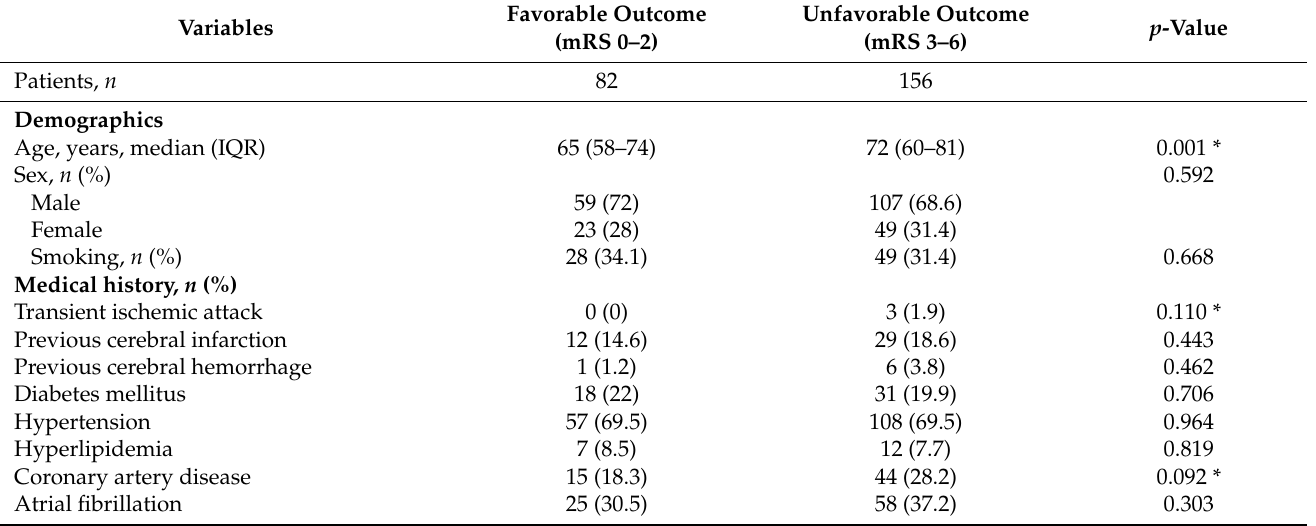
Table 1. Clinical, demographic and laboratory data of study population stratified according to three-month favorable or unfavorable outcome after acute ischemic stroke in Chinese patients with mechanical